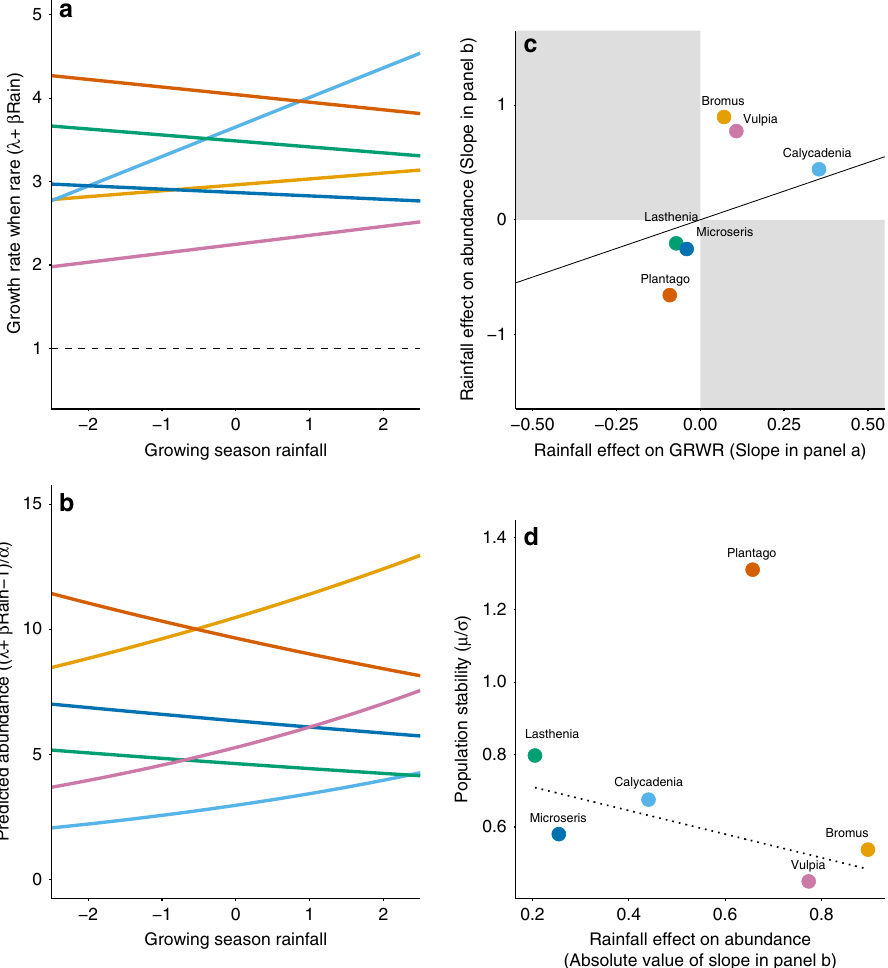
Fig. 3 Population sensitivity to climate variability depends on abundance mechanisms. a Effect of rainfall on the growth rate when rare (GRWR) of six serpentine grassland species. Rainfall is standardized such that 0 represents average conditions. b Effect of standardized rainfall on the predicted abundance of each species. c Relationship between the GRWR sensitivity to rainfall (slope of panel a ) and the responsiveness of the population to rainfall (slope of panel b ); greater NDD dampens population response to rainfall. Line indicates a one-to-one relationship; not-possible areas of the state-space are shaded. d Relationship between observed population stability and the responsiveness of the population to rainfall (absolute value of the slope of panel b ). Non-signi fi cant regression lines omits the dominant species Plantago ( R 2 = 0.42, P =